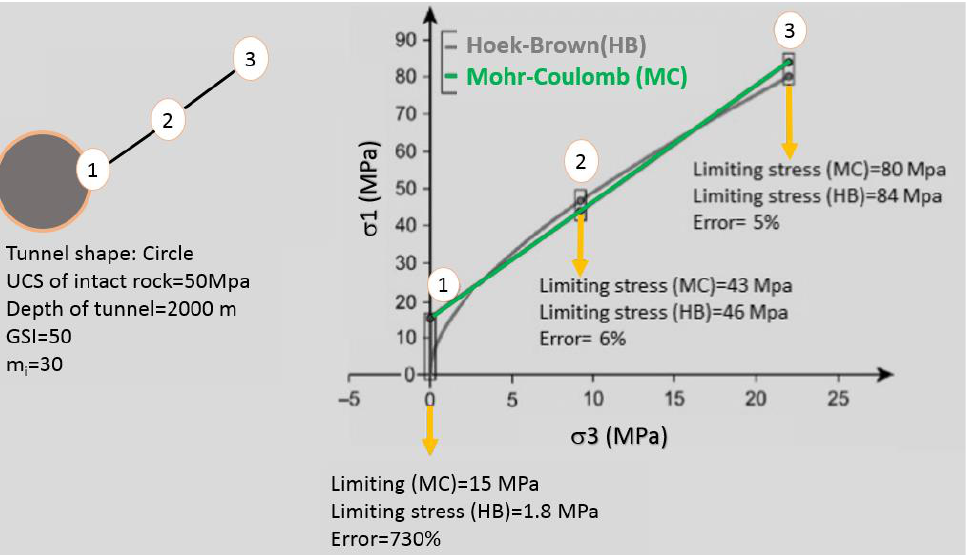
Figure 1. Differences in errors between the Mohr-Coulomb and Hoek-Brown criteria when applied to deep excavations [5].